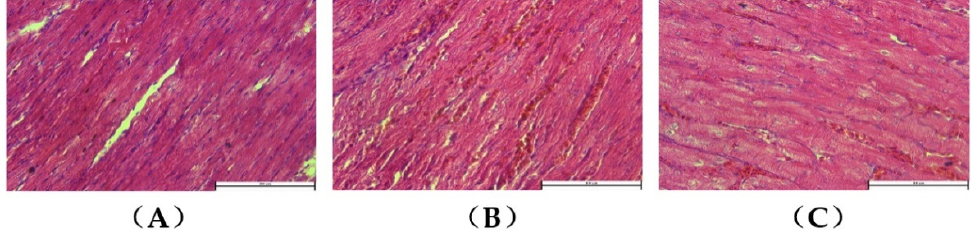
Figure 2. HE of broiler myocardial tissues (40 × ): ( A ) control group; ( B , C ) ascitic group, showing that, in some myocardial cells, the structure of myofibrils was disordered, and a large number of blood cells were deposited in the blood vessels.